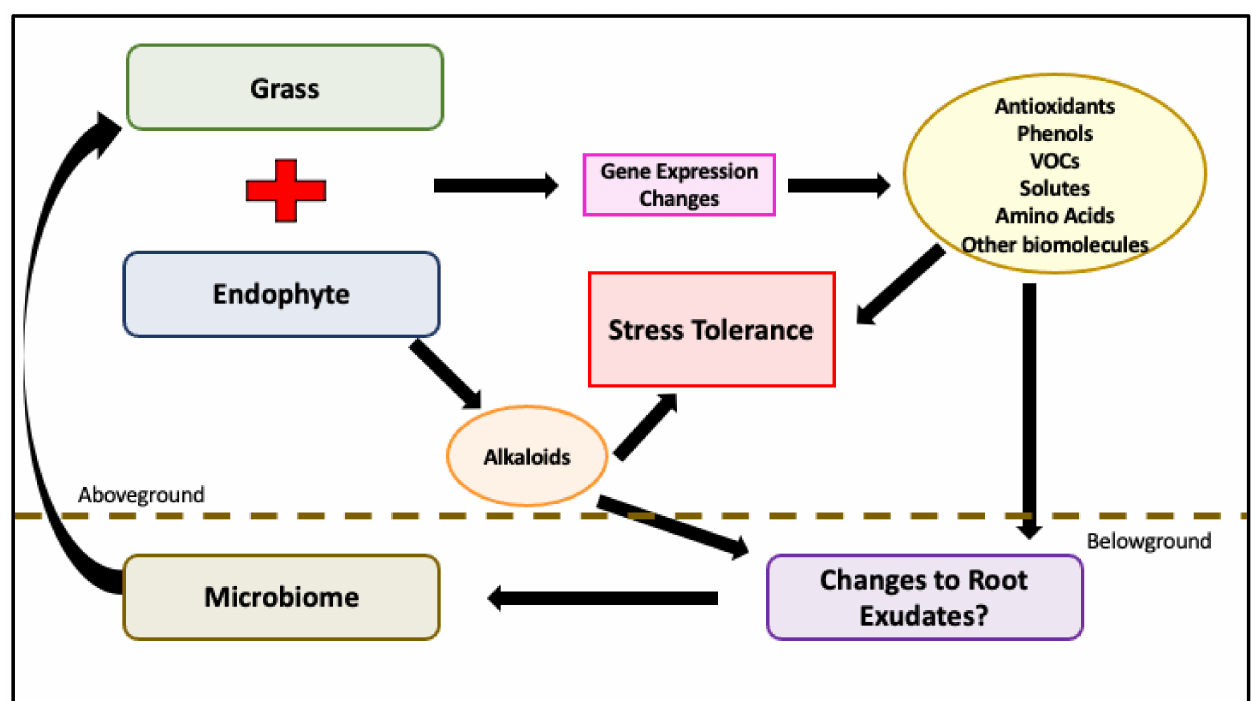
Figure 3. Diagram of proposed interactions between Epichloë endophytes, grass, stress and the microbiome. Grass infection with the endophyte leads to gene expression changes, which alters the production of a host of different compounds. The endophyte produces alkaloids. Alkaloids and the protective compounds produced lead to better stress tolerance of the grass. The same compounds and alkaloids may also have an effect on root exudates secreted by the grass into the soil. This could impact the microorganism present there, which in turn has a feedback effect on the grass. Arrows indicate how one change leads to another in the feedback